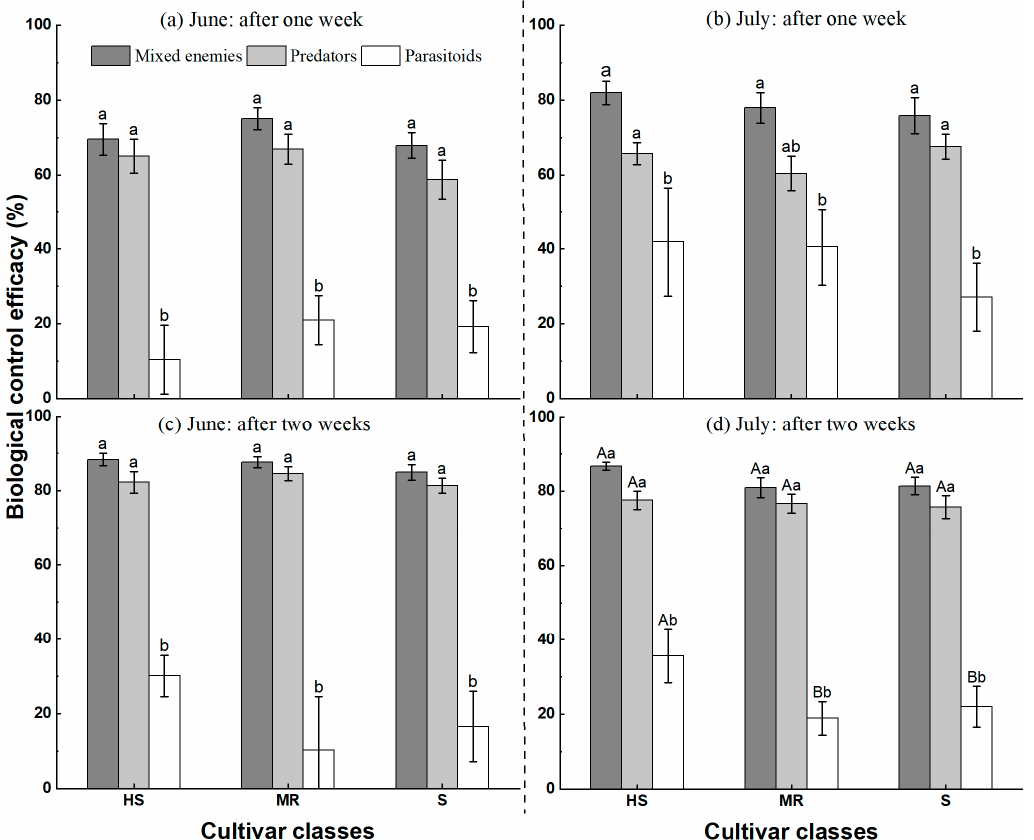
Figure 4. The mean (±SEM) biological control efficacy of natural enemies against the pea aphid, Acyrthosiphon pisum , on three cultivar classes (HS = Highly susceptible; MR = Moderate Resistance; S = Susceptible) in a field experiment in Ningxia Province, China, in 2019. Note: The left represents the period in June after the first harvest, and the right represents the period in July after the second harvest. Different capital letters indicate significant differences among cultivar classes ( p < 0.05), and different lower-case letters show significant differences among natural enemies ( p < 0.05). Ac- cording to Table 3, capital letters were marked only when they were significant between treatments (HS = Highly susceptible; MR = Moderate Resistance; S =